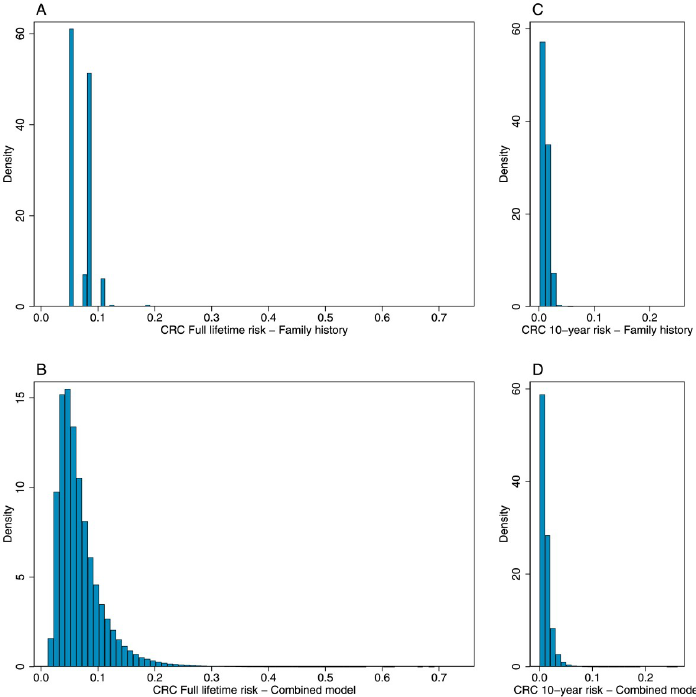
Fig 1. Risk distribution plots for the eligible UK Biobank participants. Plots show the Full lifetime risk distribution for a model with family history only (A) and the combined model (B), and 10-year risk for the family history model (C) and the combined model